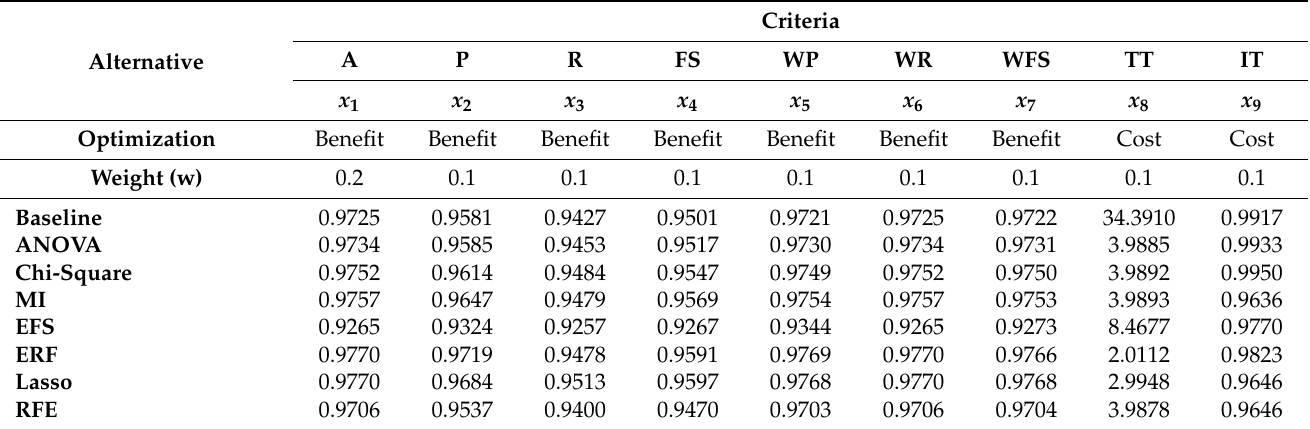
Table 4. Initial decision-making matrix X